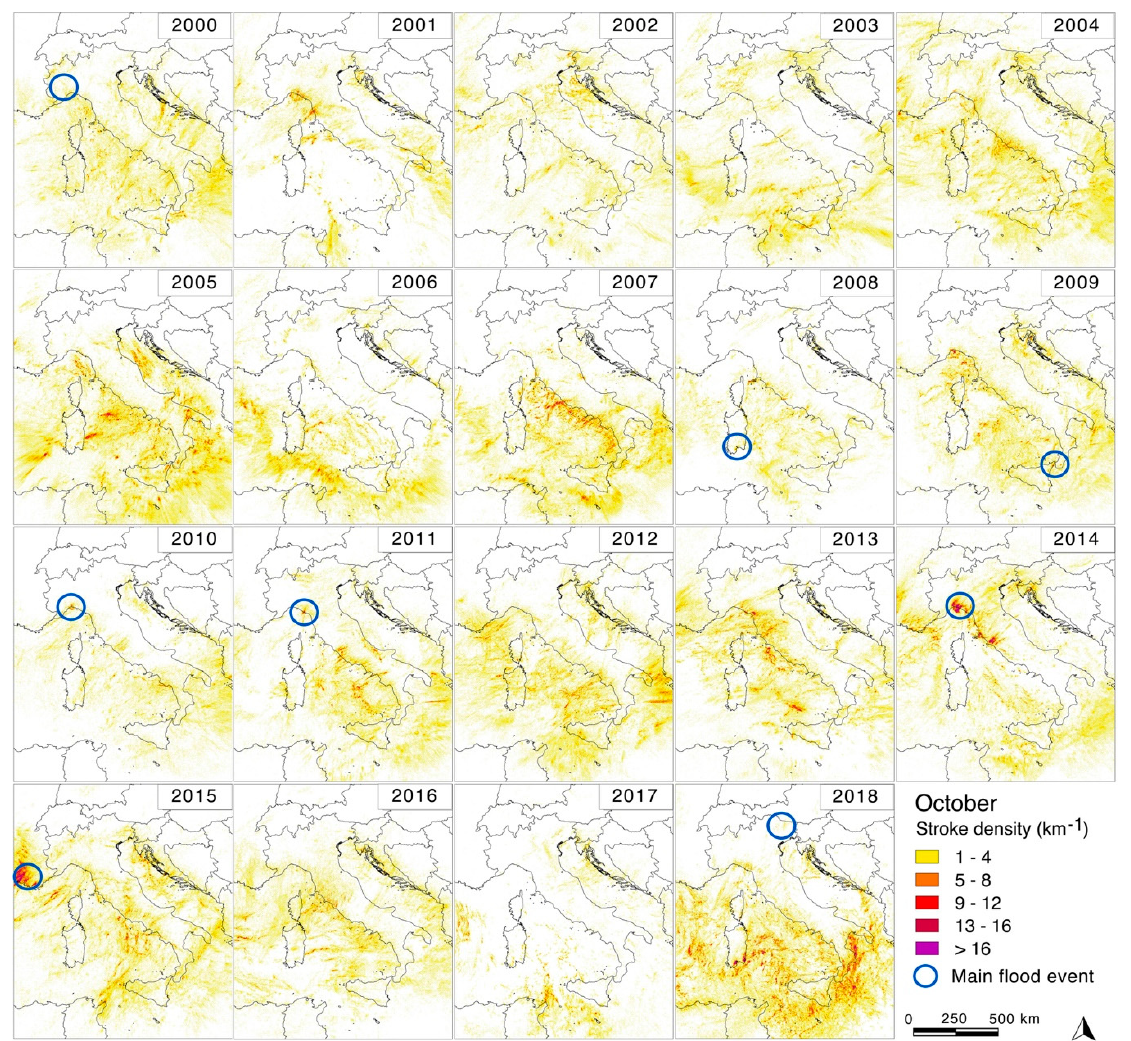
Figure 6. Cloud–ground strokes per square km in October for the entire period. Blue open circles indicate main flood events.